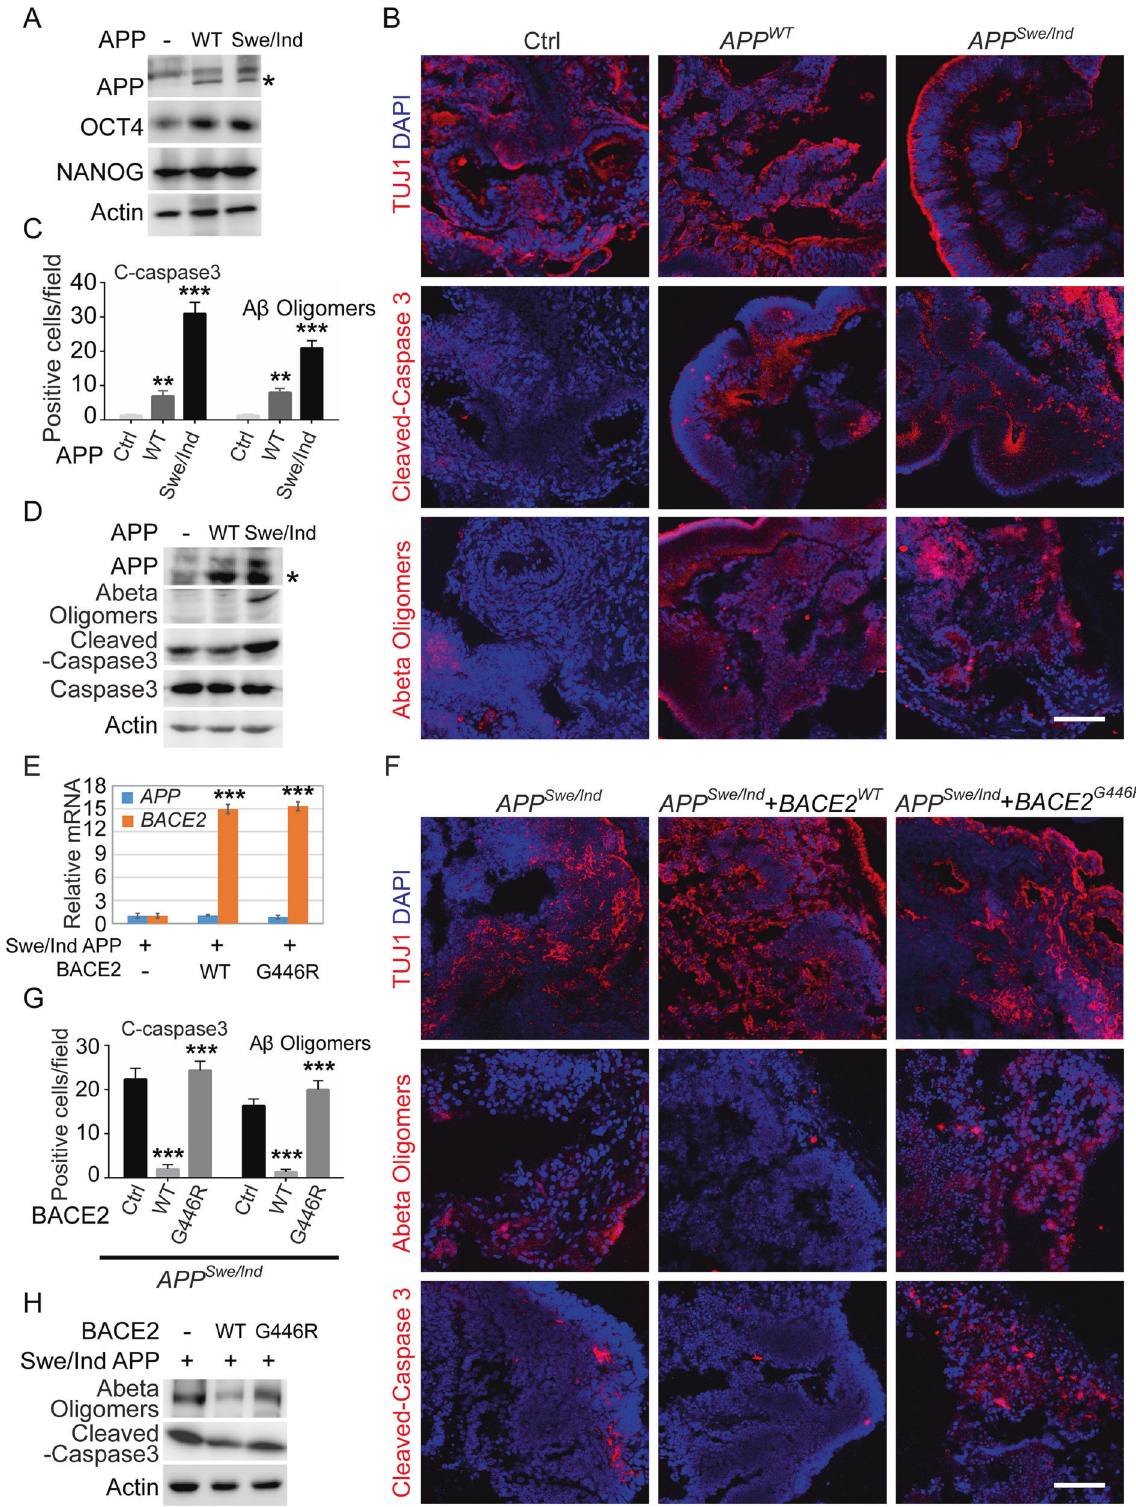
Fig. 4 BACE2 overexpression in BOs with family AD mutations attenuates AD-associated phenotypes. A Western blot analyses of total proteins from hPSCs stably overexpressed WT and APP Swe/Idl using the indicated antibodies. B – D Representative images and quanti fi cation of the cellular apoptosis and A β accumulation evaluated by immunostaining and western blotting analysis using the indicated antibodies. Scale bar: 100 μ m. E qRT-PCR analysis of the mRNA level of APP and BACE2 in hPSCs stably overexpressed with WT and APP Swe/Idl . F – H Representative images and quanti fi cation of the cellular apoptosis and A β accumulation evaluated by immunostaining and western blot analysis using the indicated antibodies. Scale bar: 100 μ m.